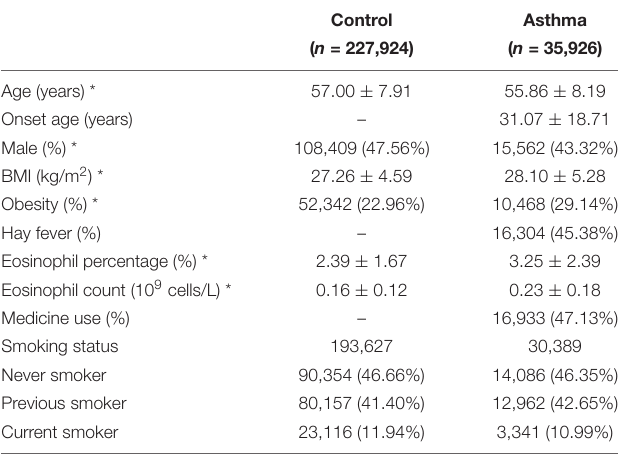
TABLE 1 | Characteristics of the asthma cases and controls from the UK